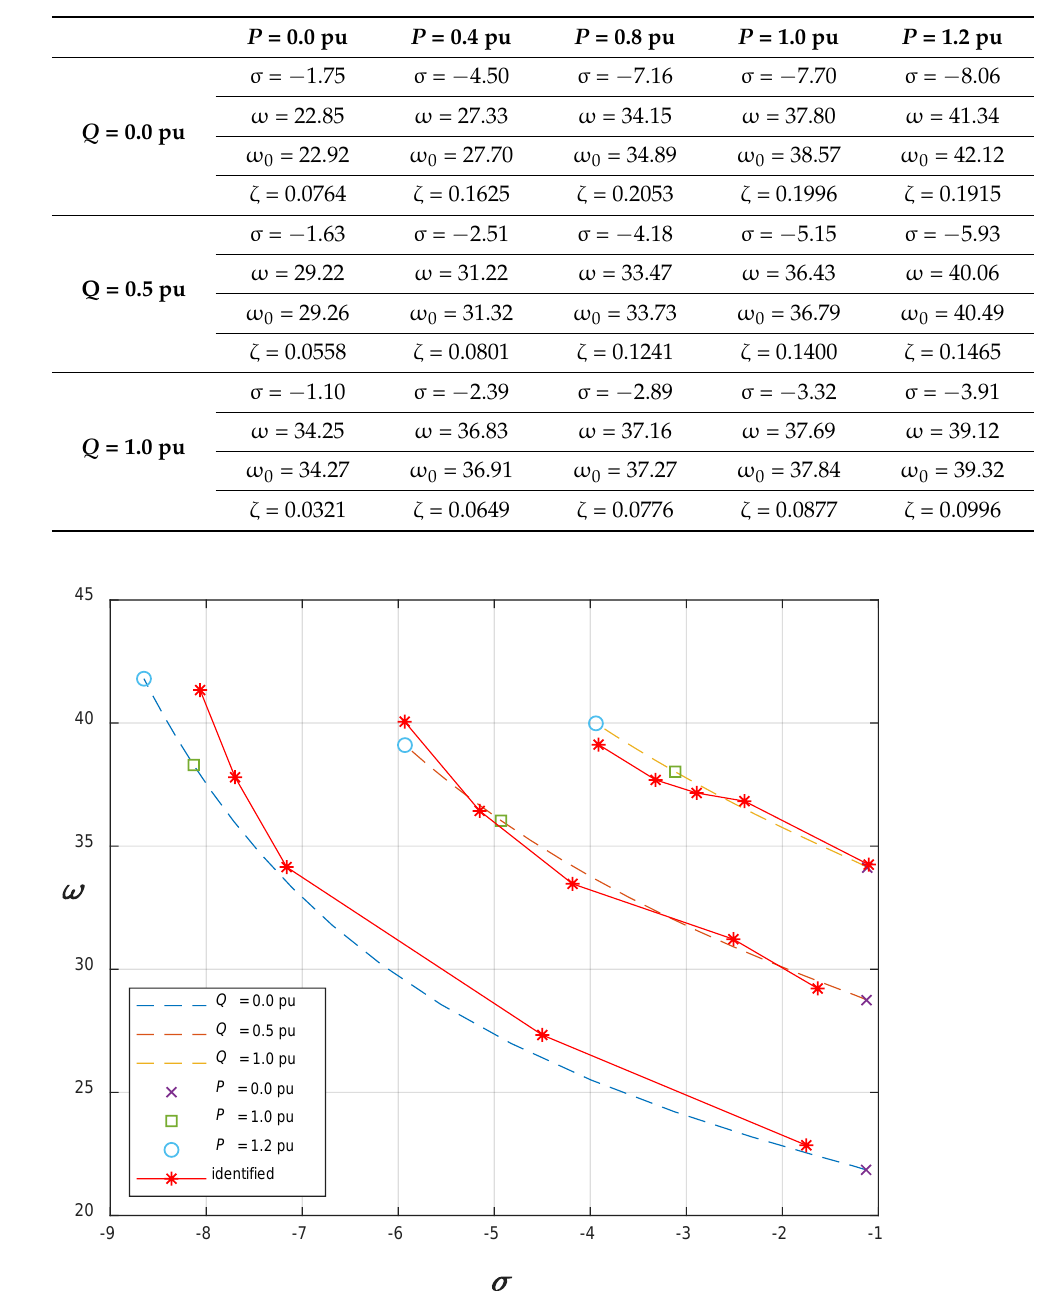
Figure 23. Eigenvalue loci of the local mode of the laboratory synchronous generator P n = 12 kW obtained with numerical analysis of an H–P model and with identification of the measured time responses of the oscillations conducted with step changes of the mechanical torque.